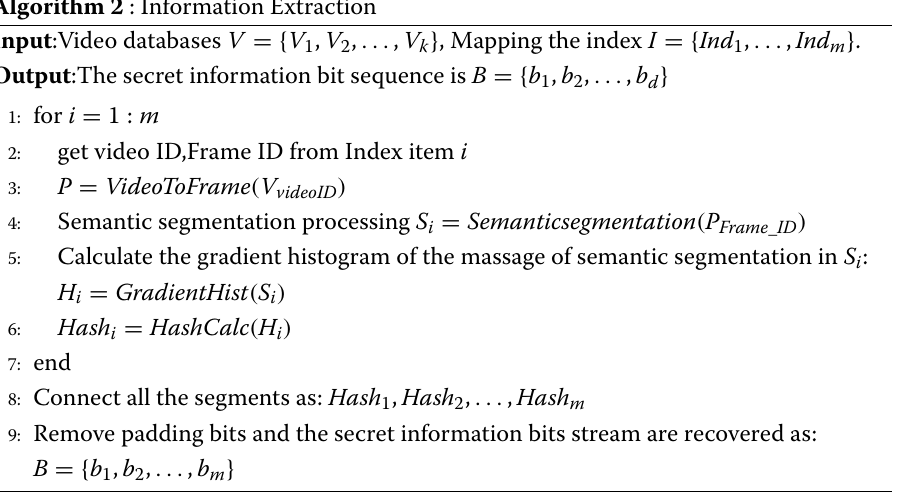
Algorithm 2 : Information